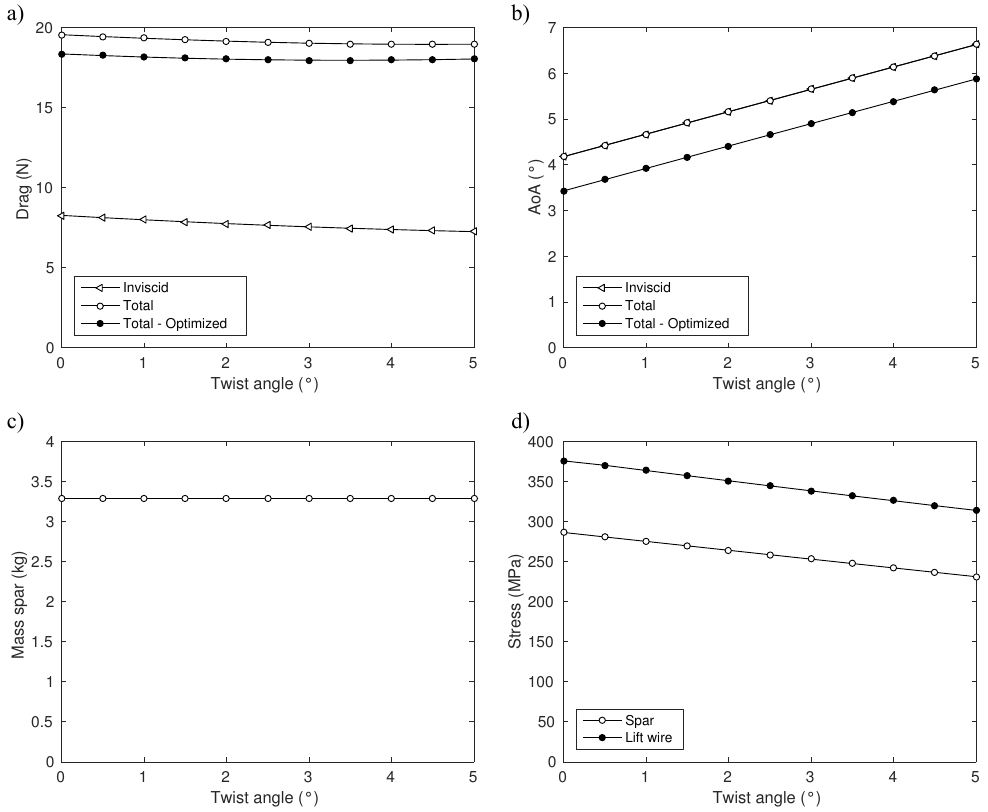
Figure 21. Sensitivity study: twist angle. ( a ) Drag; ( b ) angle of attack; ( c ) mass of the spar; ( d ) maximal